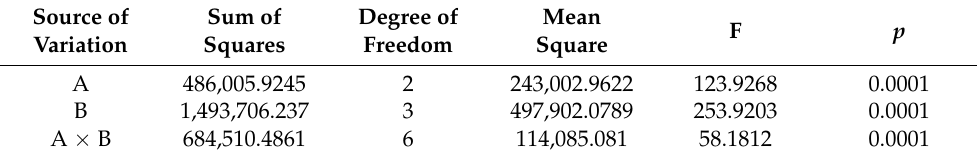
Table 3. Analysis of variance of Mn deficiency on root length of maize seedlings of different genotypes.